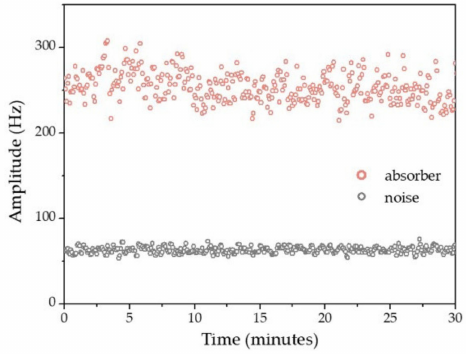
Figure 11. Photoacoustic (PA) amplitude extracted from the B-Scan maximum intensity projection (MIP) image of human hairs as absorbers for 30